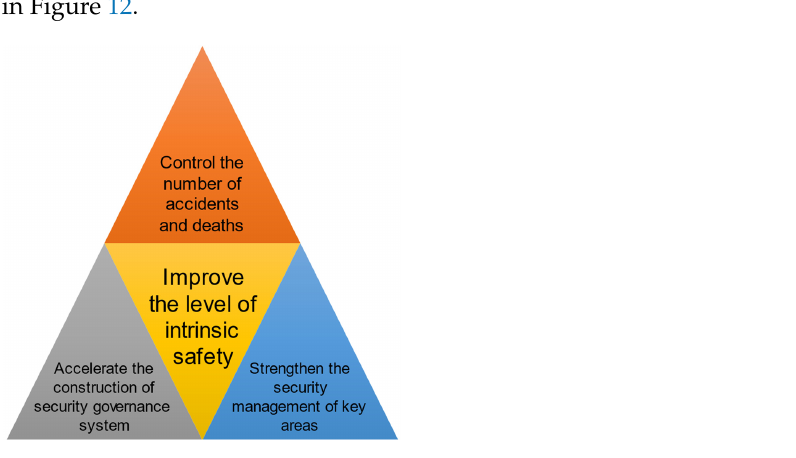
Figure 12. China’s hazardous chemical industry safety management development goals.